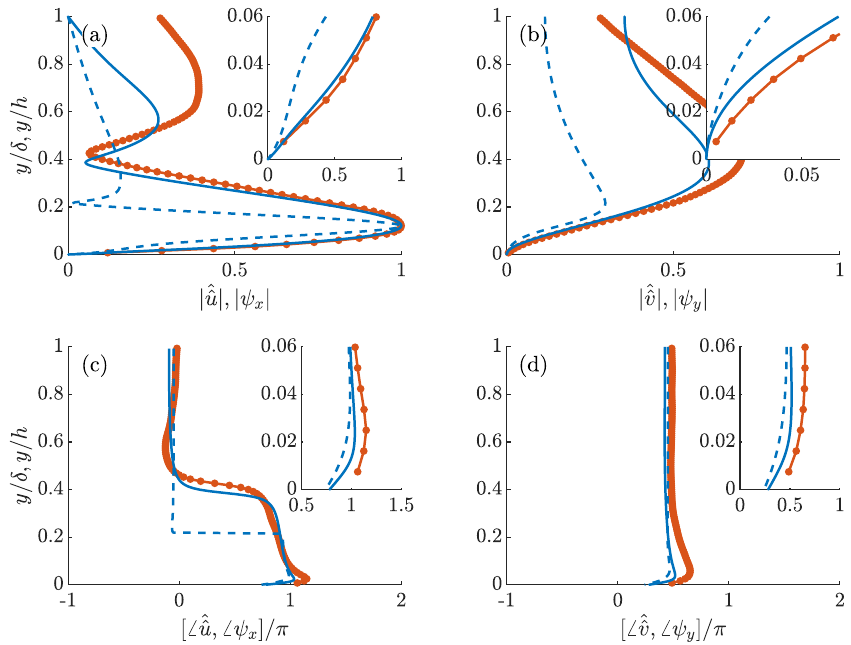
Figure 7. Comparison of the ( a , b ) amplitude and ( c , d ) phase between the experimental results (red solid lines with circle markers), the resolvent modes (blue dash lines), and the resolvent modes with eddy viscosity (blue solid lines) for the rigid wall case. Figures ( a , c ) are the streamwise modes, and ( b , d ) are the wall-normal modes. Markers for the experimental results indicate locations where measurements were taken. Mode amplitudes are normalized by their peak streamwise amplitude, and phases are matched at the peak location. Insets are the near wall close-up views for y / h , y / δ ≤ 0.06. Parameters for resolvent analysis are Re τ = 410, ( k x , k z , c + ) = ( 2.67,0,14.51 ) , and Re τ = 410, ( k x , k z , c + ) = ( 2.67,0,15.46 ) , without and with eddy viscosity,